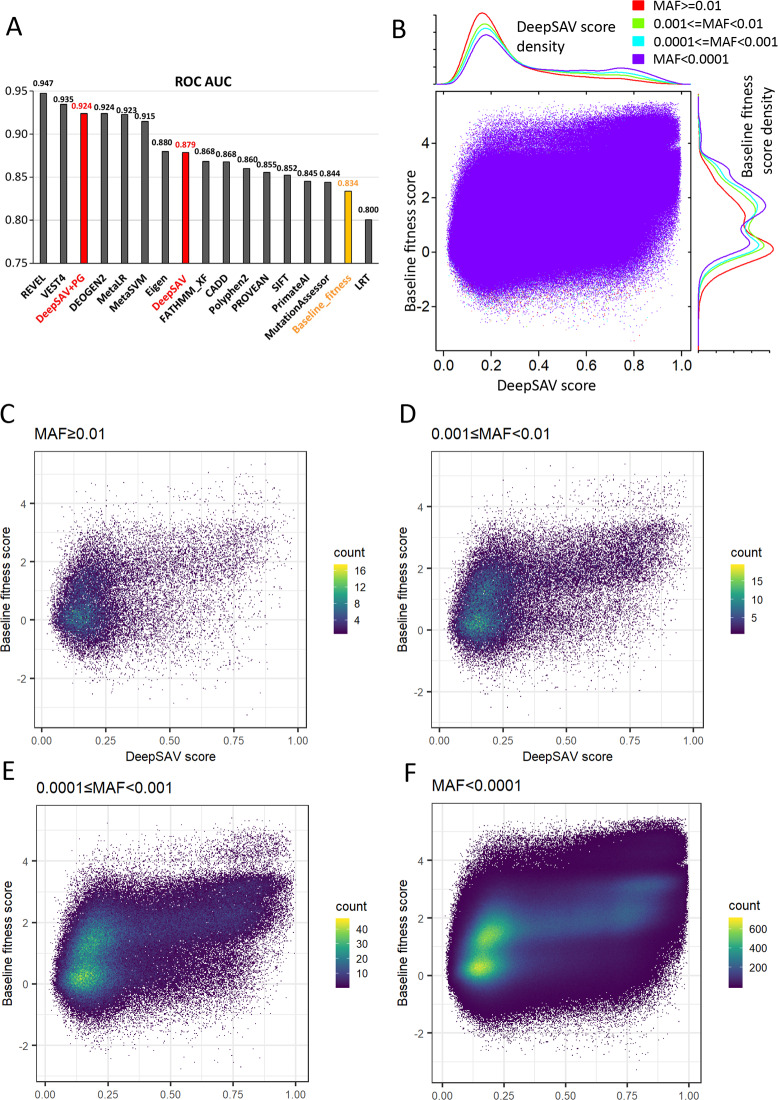
A) Performance of variant pathogenicity prediction programs in terms of AUC (area under the ROC curve) measure. B) Scatter plot of DeepSAV scores and baseline fitness scores for SAVs observed in gnomAD. Datapoints for four different MAF categories are shown. Their density plots are shown by the axes above (DeepSAV) and right (baseline fitness). C) to F) Two-dimensional histograms (made with R ggplot2 package) of DeepSAV scores and baseline fitness scores for gnomAD variants with MAF ≥ 0.01 (C), 0.001 ≤ MAF < 0.01 (D), 0.0001 ≤ MAF < 0.001 (E), and MAF < 0.0001 (F).